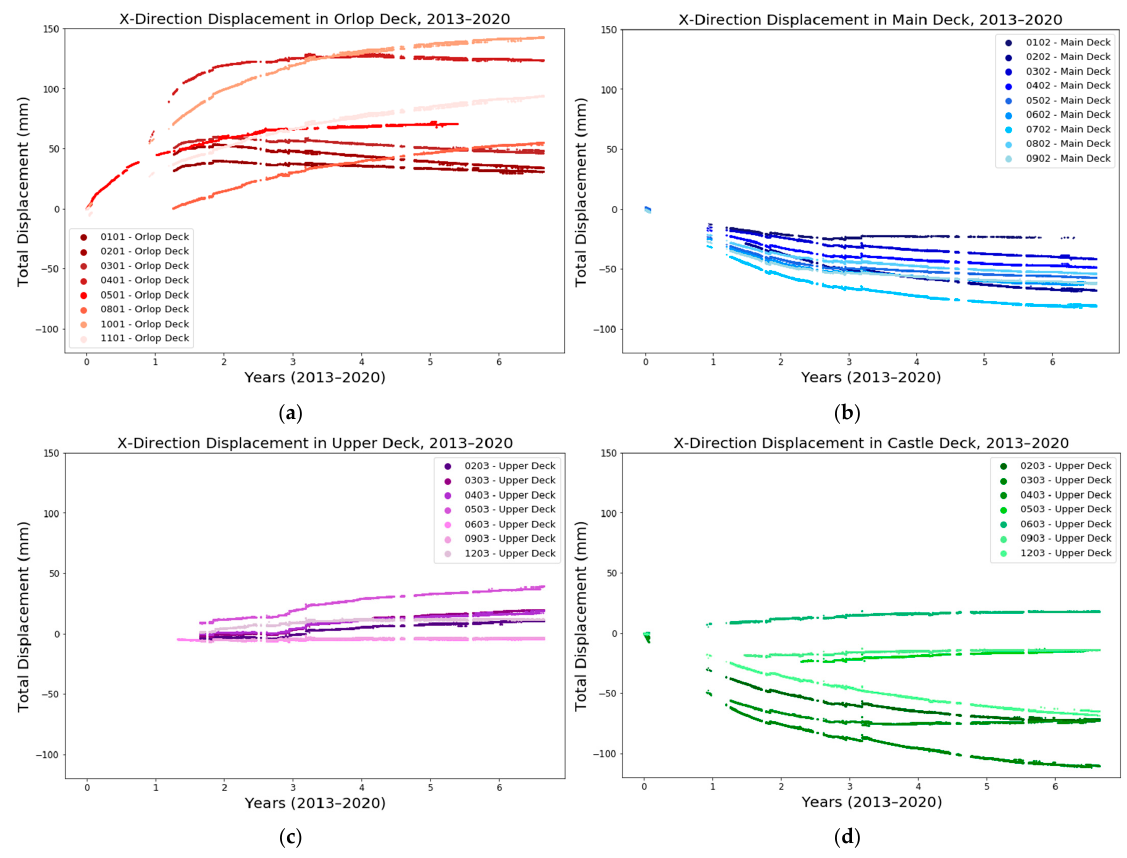
Figure 3. X direction displacement of the TS targets in the ( a ) orlop, ( b ) main, ( c ) upper and ( d ) castle decks plotted against time for the period between September 2013 and March 2020. The displacement along the X direction in the ship experienced a concertina motion as the direction of the displacement flipped between each deck. The direction of displace- ment in the X direction is consistent across each deck, with an average of +60 ± 40 mm for the orlop deck, +20 ± 9 mm for the upper deck, − 60 ± 20 mm for the main deck and − 60 ± 30 mm for the castle deck. The orlop deck and the castle deck have displaced further than the main and upper decks. This is potentially because the orlop deck does not have the titanium support beams that the other decks have, and the castle level is the least inter- connected. Displacement in the Y direction is shown in Figure 4. The displacement along Y av- eraged at approximately − 20 ± 10 mm in the orlop deck, +10 ± 10 mm in the main deck, − 60 ± 30 mm in the upper deck and − 150 ± 80 mm in the castle deck. The target with the greatest displacement between 2013 and 2020 is the 06.04 target, towards the centre of the castle deck, which has displaced by 250 mm.